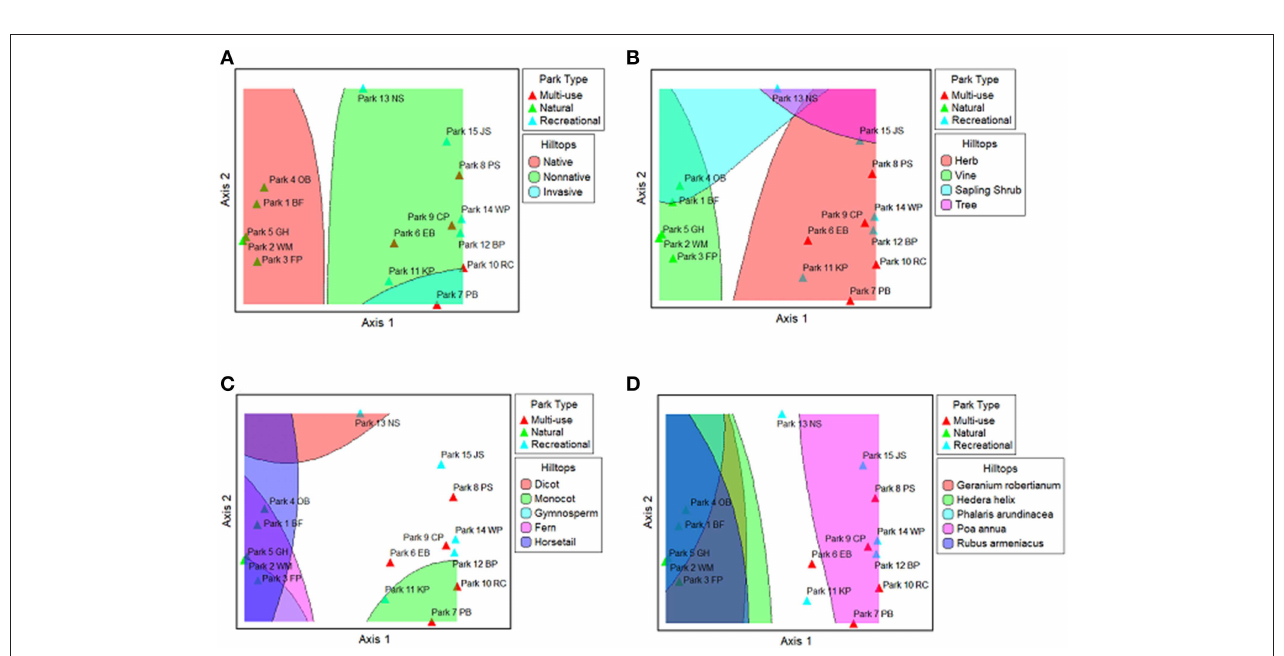
FIGURE 9 | NMS ordination Axes 1 and 3 for the parks in species space. Trait variables that are strongly related to the individual ordination axes ( r 2 > 0.2) are shown as joint plots (radiated red lines).